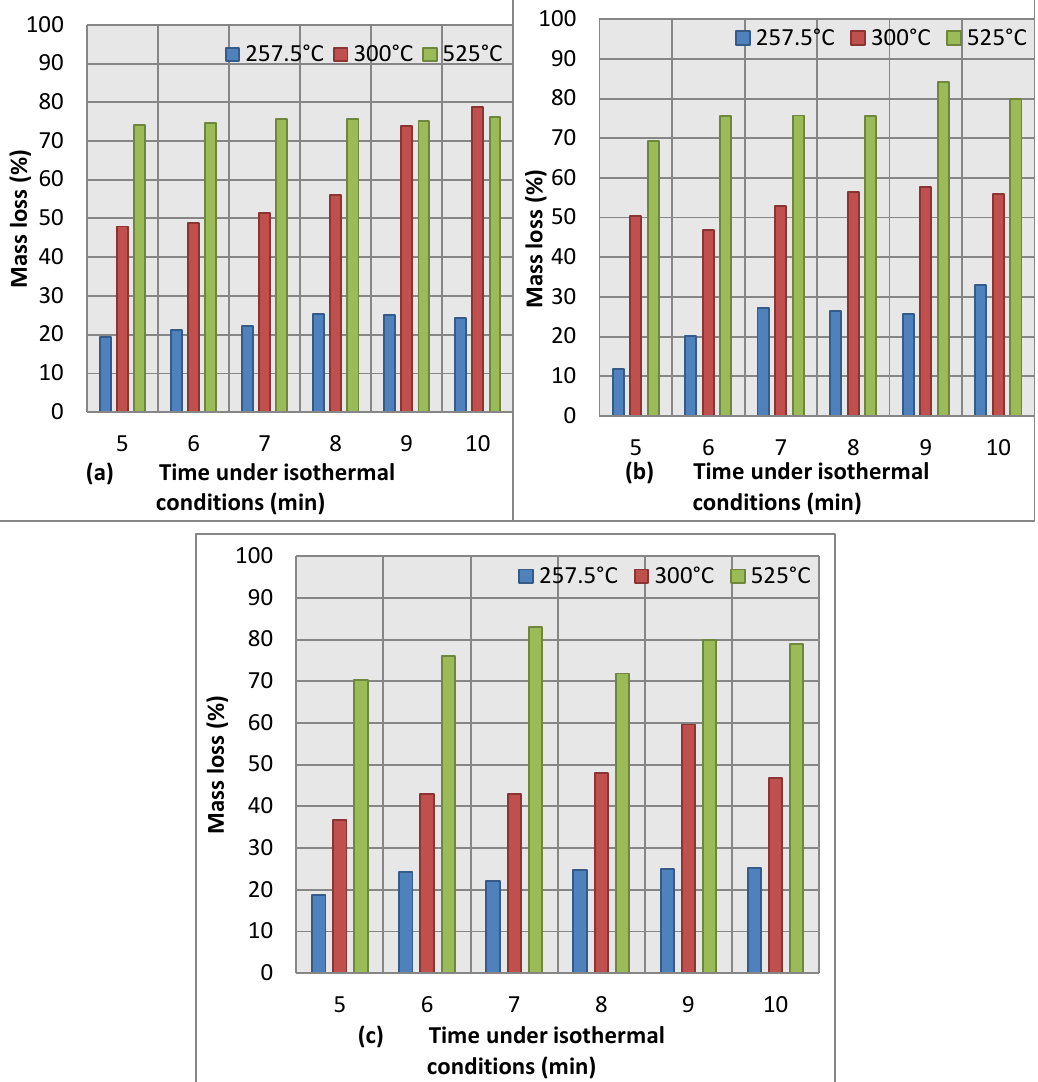
Figure 16. Oat straw torrefaction process TGA analysis results and process conditions as in temperature and optimal mass loss for production of biofuel, additive for natural fertilizers, activated carbon (Figures 16 ( a ) heating rate 5 K/min, 16 ( b ) 10 K/min, 16 ( c ) 20 K/min).